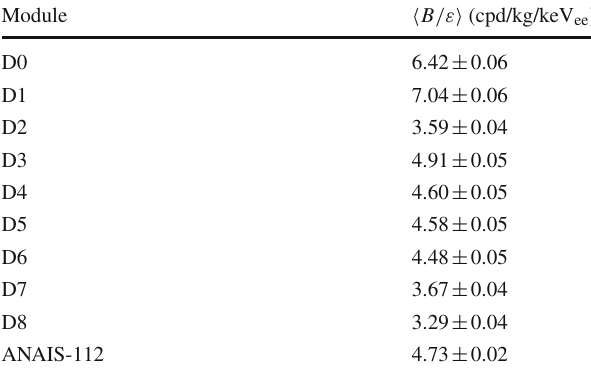
Table2 (cid:9) B /ε (cid:10) calculatedfrommeasured ∼ 10%unblindedbackground in the [1,6] keV ee energy interval for all modules after filtering and efficiencycorrectionhavebeenapplied.TheaveragevaluesforANAIS- 112 are listed in the last row